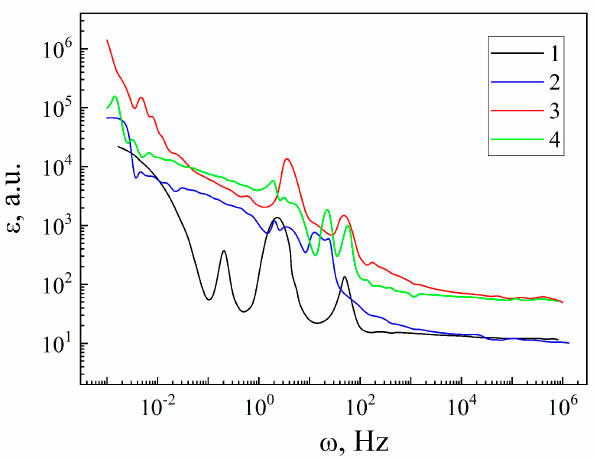
Figure 6. Frequency dependences of the dielectric constants of the matrix MSM-41 (1) and encapsulate MSM-41<SFA>, measured under normal conditions (2), in a magnetic field (3), and under illumination (4).